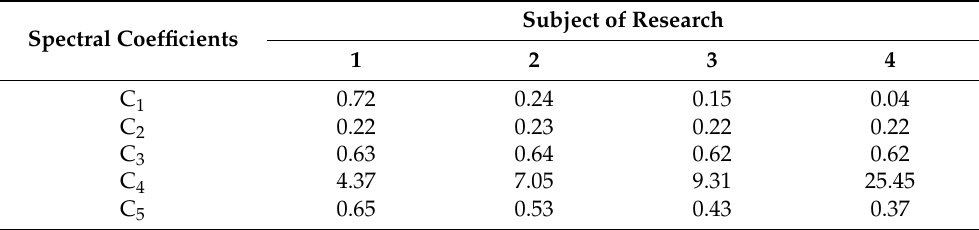
Table 5. Results of IR spectral analysis of resins.